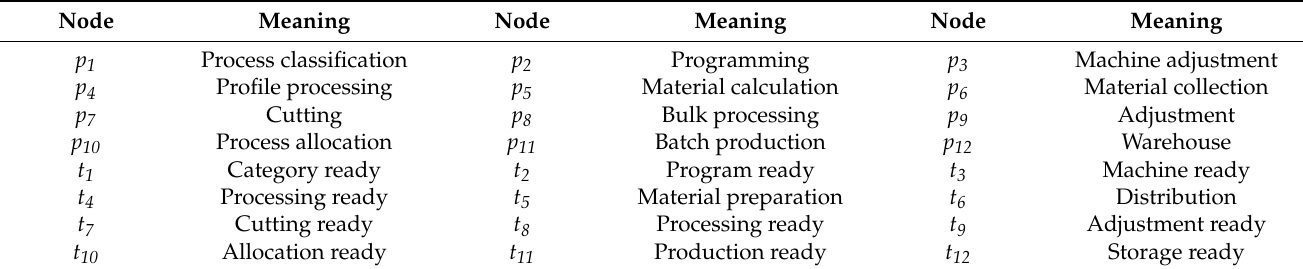
Table 1. Sheet metal manufacturing process node sets P and T